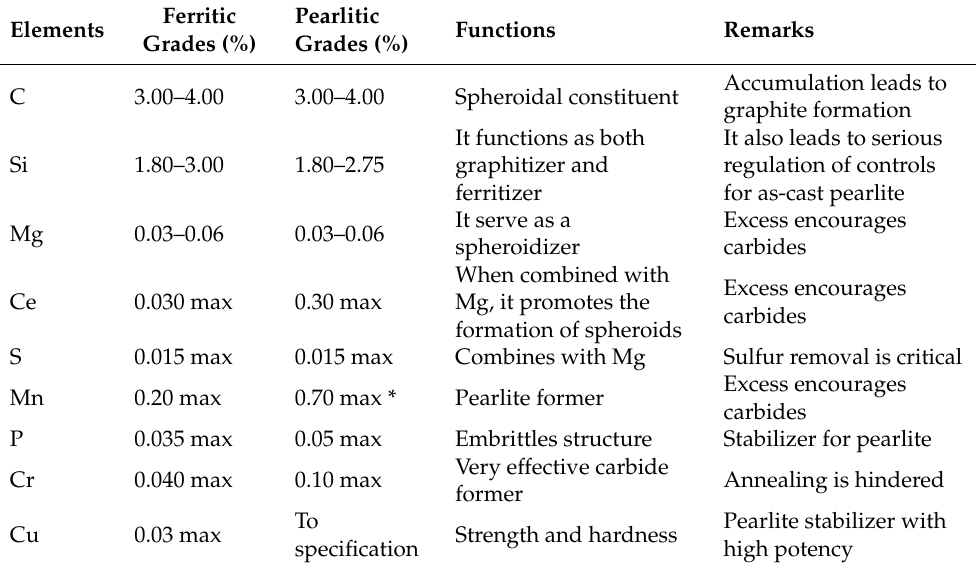
Table 1. Ranges of chemical composition for DI casting